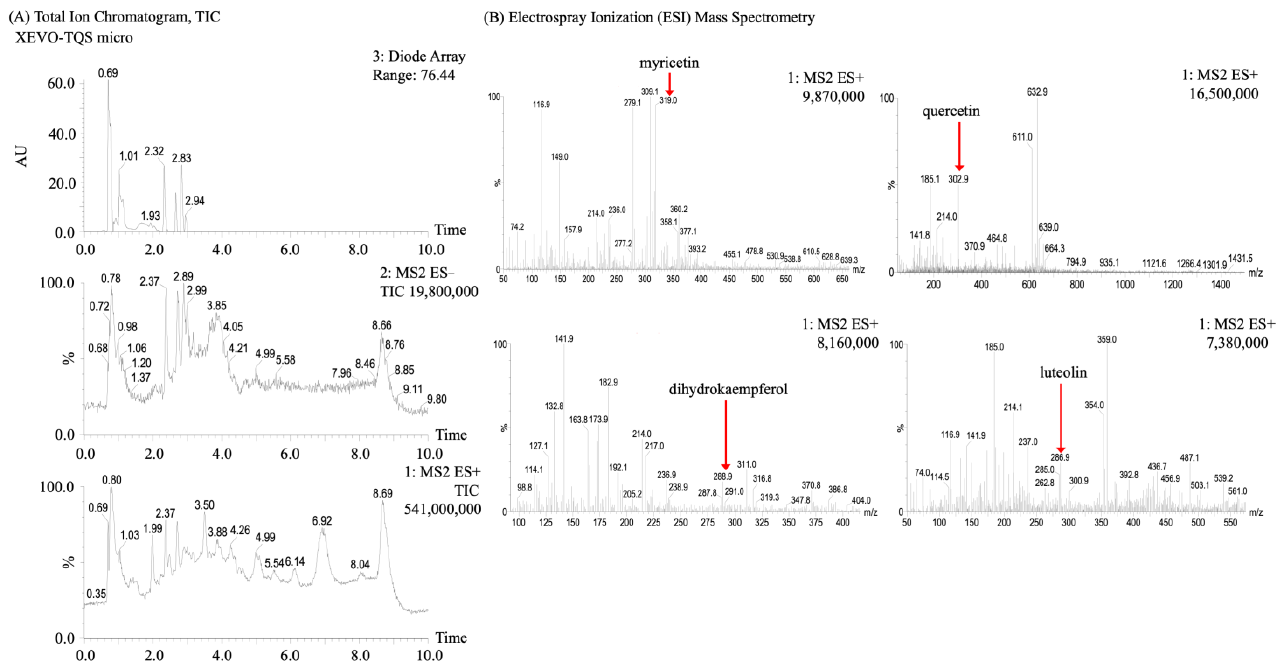
Figure 3. HPLC – ESI – MS total ion chromatograms of malanto extracts. ( A ) HPLC – ESI – MS total ion Figure 3. HPLC–ESI–MS total ion chromatograms of malanto extracts. ( A ) HPLC–ESI–MS total ion chromatogram of malanto total extract; ( B ) HPLC – ESI – MS total ion chromatogram of malanto ex- chromatogram of malanto total extract; ( B ) HPLC–ESI–MS total ion chromatogram of malanto extract tract flavonoids.